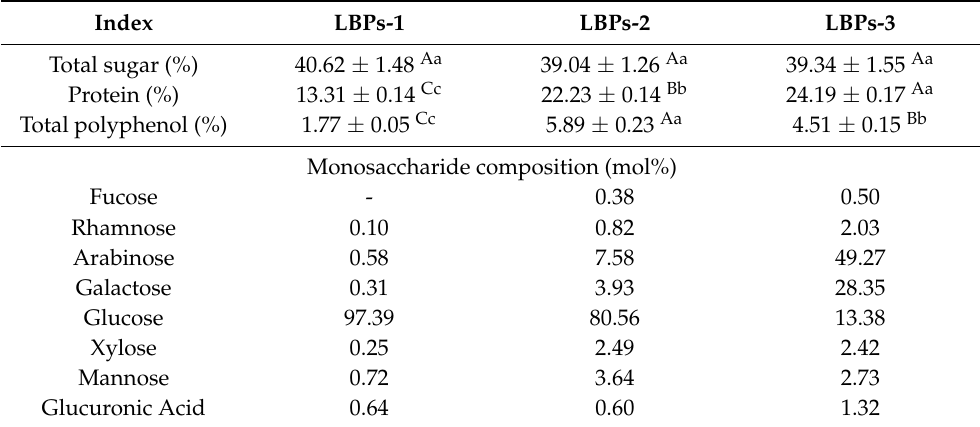
Table 3. Effects of different molecular weights of LBPs on chemical properties and monosaccharide